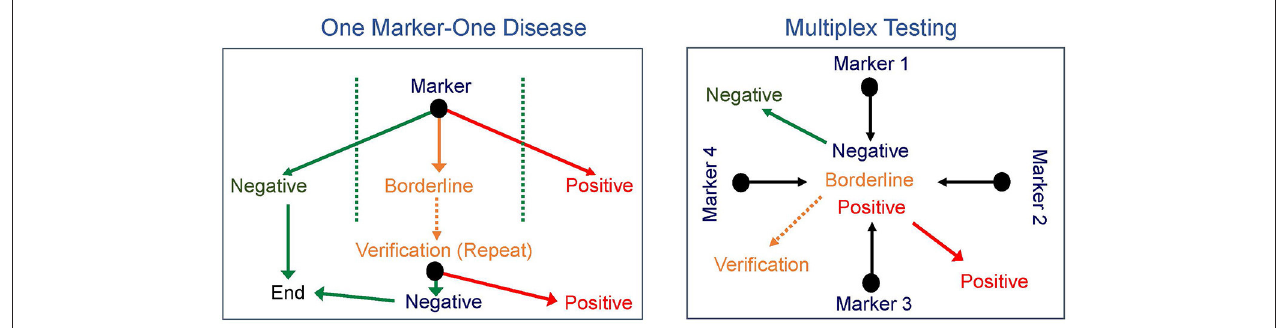
FIGURE 1 | Newborn screening paradigms. Newborn screening progressed from one marker for each disease (left) to multiplex testing with multiple markers identified from a single test (right) broadening the scope of initial screening tests and significantly increasing the differential diagnosis of a positive newborn